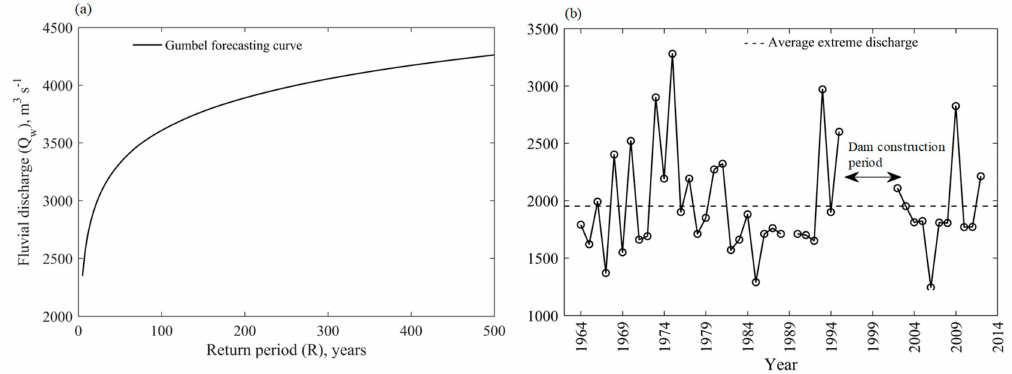
Figure 8. ( a ) Gumbel flood return period, ( b ) extreme fluvial